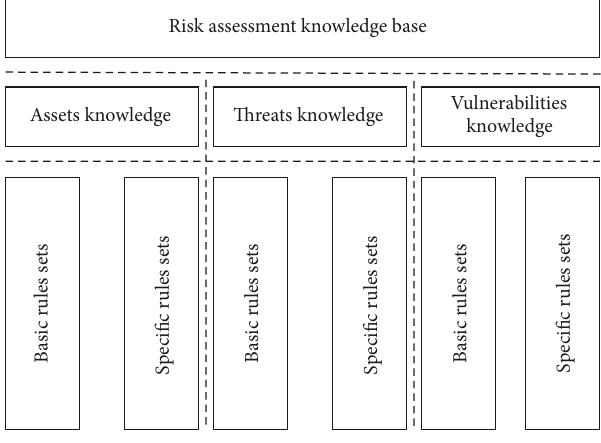
Figure 4: The architecture of risk assessment knowledge